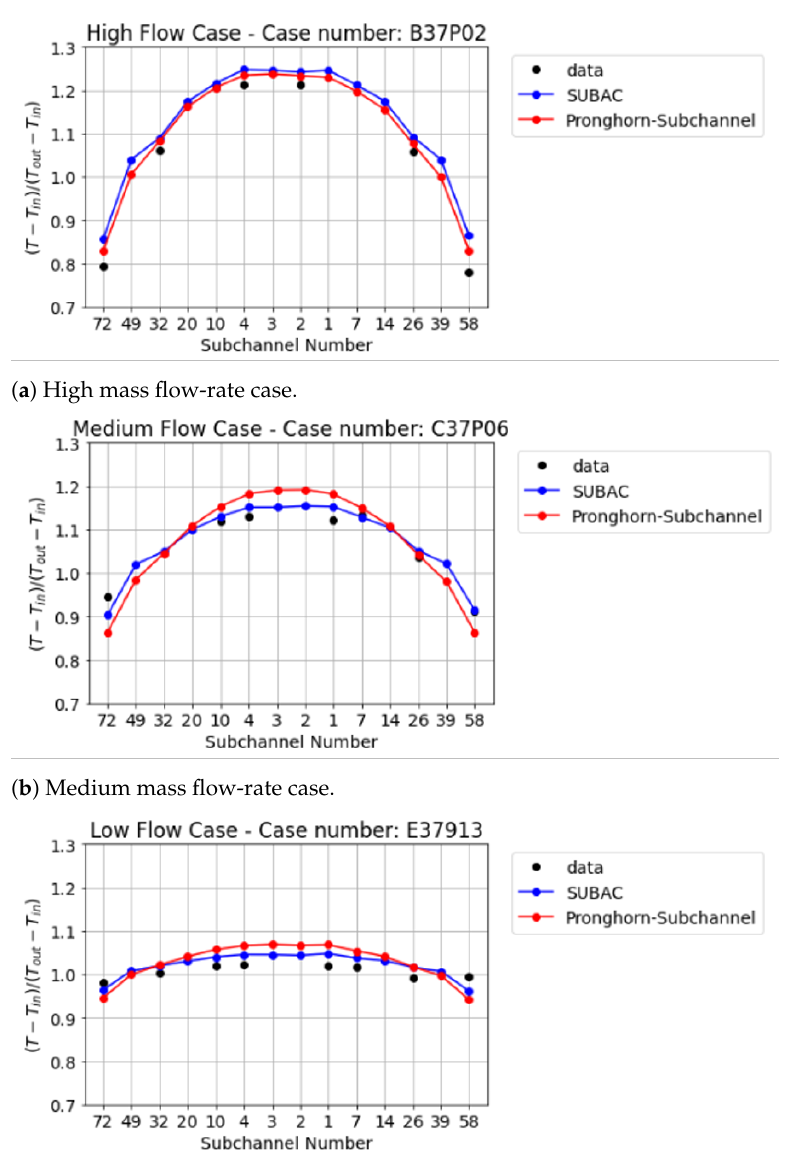
Figure 10. Comparison of results obtained for Toshiba 37-pin case between experimental measure- ments, the SUBAC code and Pronghorn-SC. ( a ) High mass flow-rate case. ( b ) Medium mass flow-rate case. ( c ) Low mass flow-rate